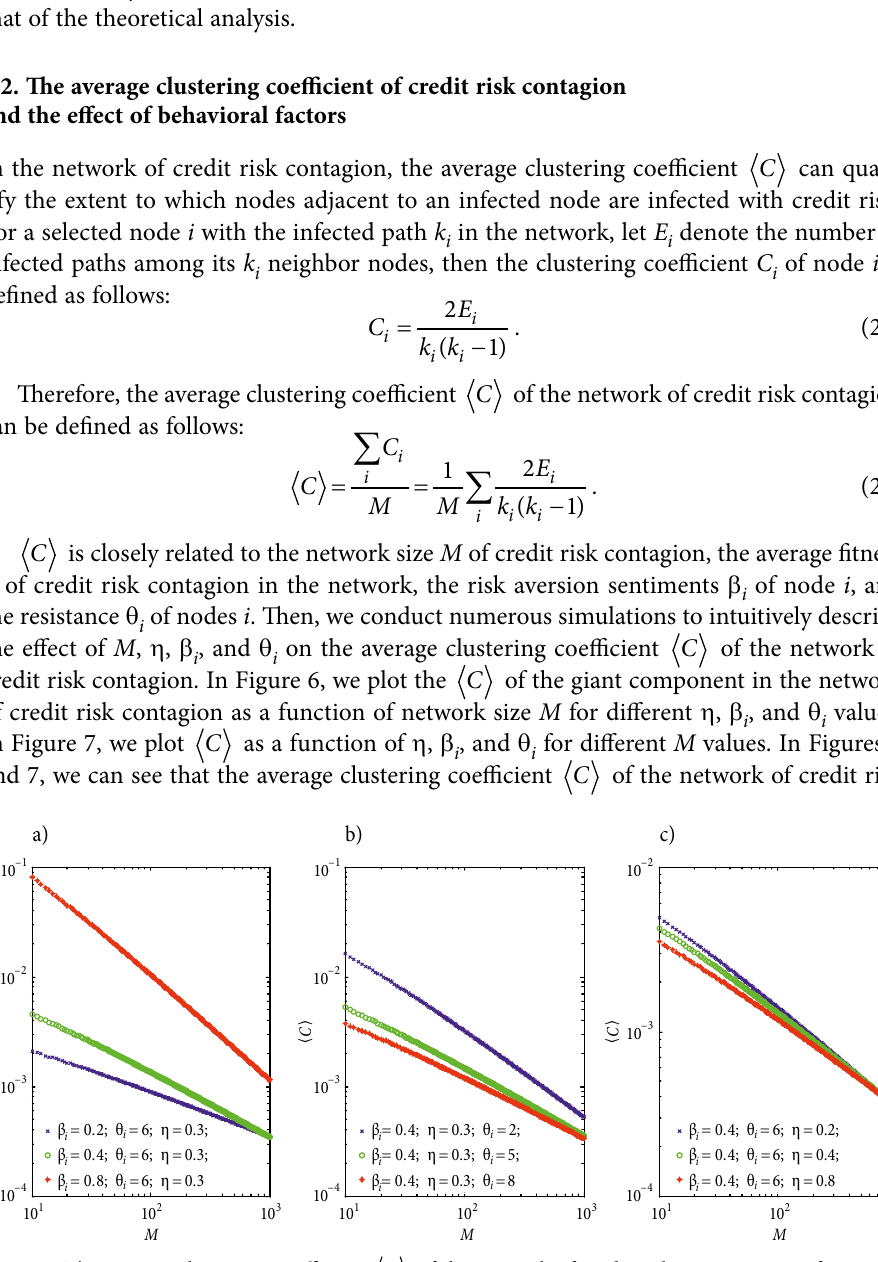
Fig. 6. The average clustering coefficient C of the network of credit risk contagion as a function of network size M , for (a) the average fitness h of credit risk contagion in the network, (b) the risk aversion sentiments b of node i on credit risk contagion, i and (c) the resistance